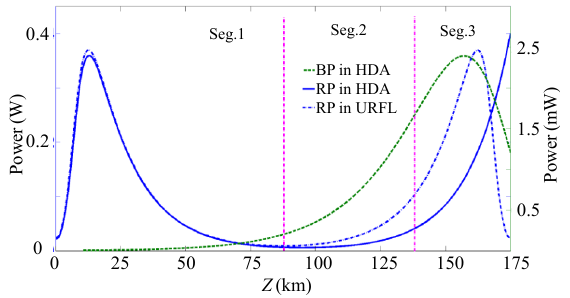
Fig. 7 Power distribution of 1 455 nm RP and 1 550 nm